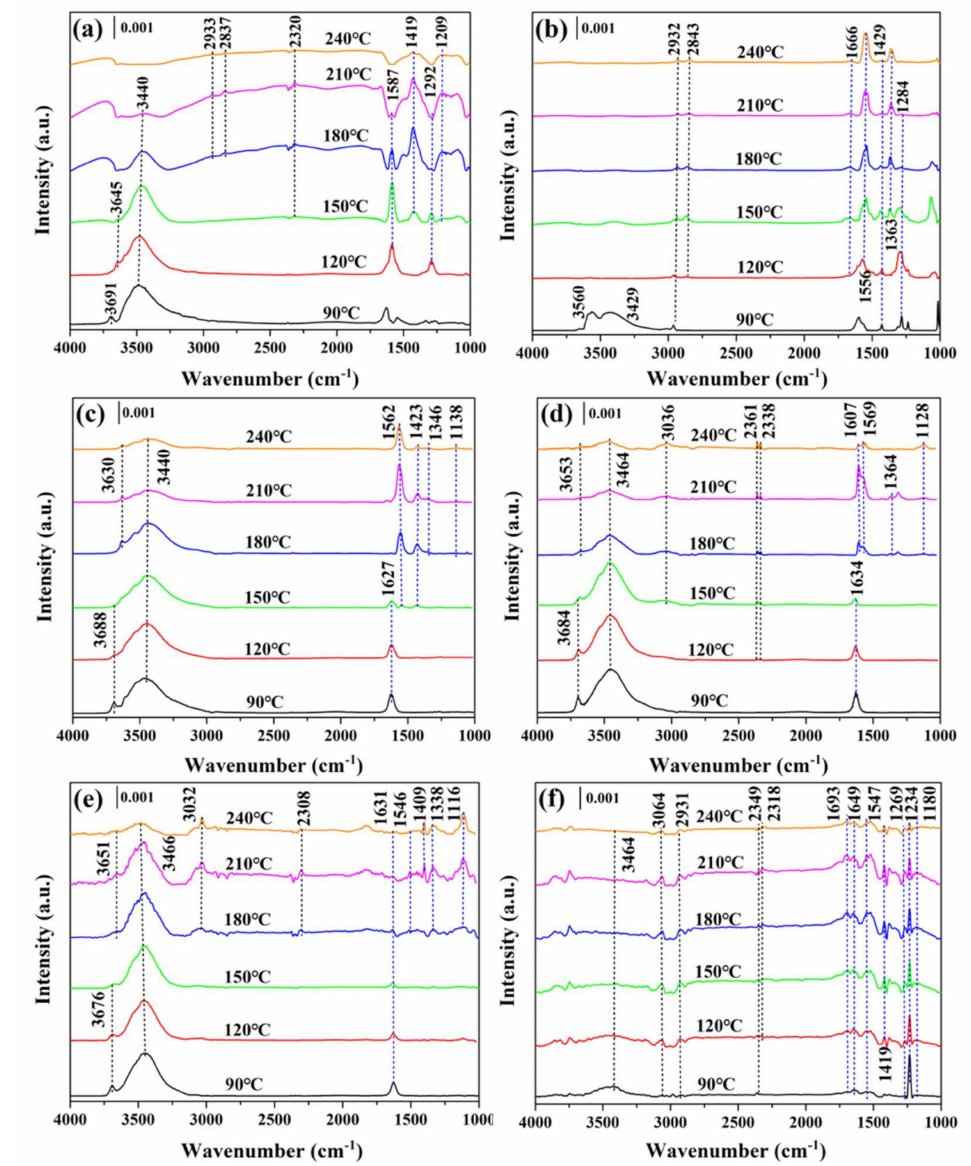
Figure 10. In situ diffuse reflectance infrared spectroscopy (DRIFTS) of 1,2–DCE catalytic oxidation: ( a ) CeO 2 , ( b ) V 0.025 Ce, ( c ) V 0.05 Ce, ( d ) V 0.1 Ce, ( e ) V 0.2 Ce, and ( f ) VO x